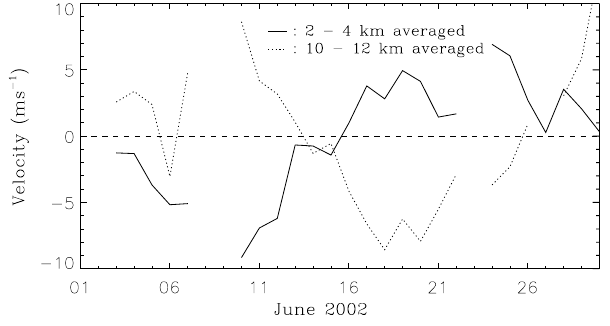
Fig. 7. Time-altitude plot of zonal wind observed by EAR in June 2002.